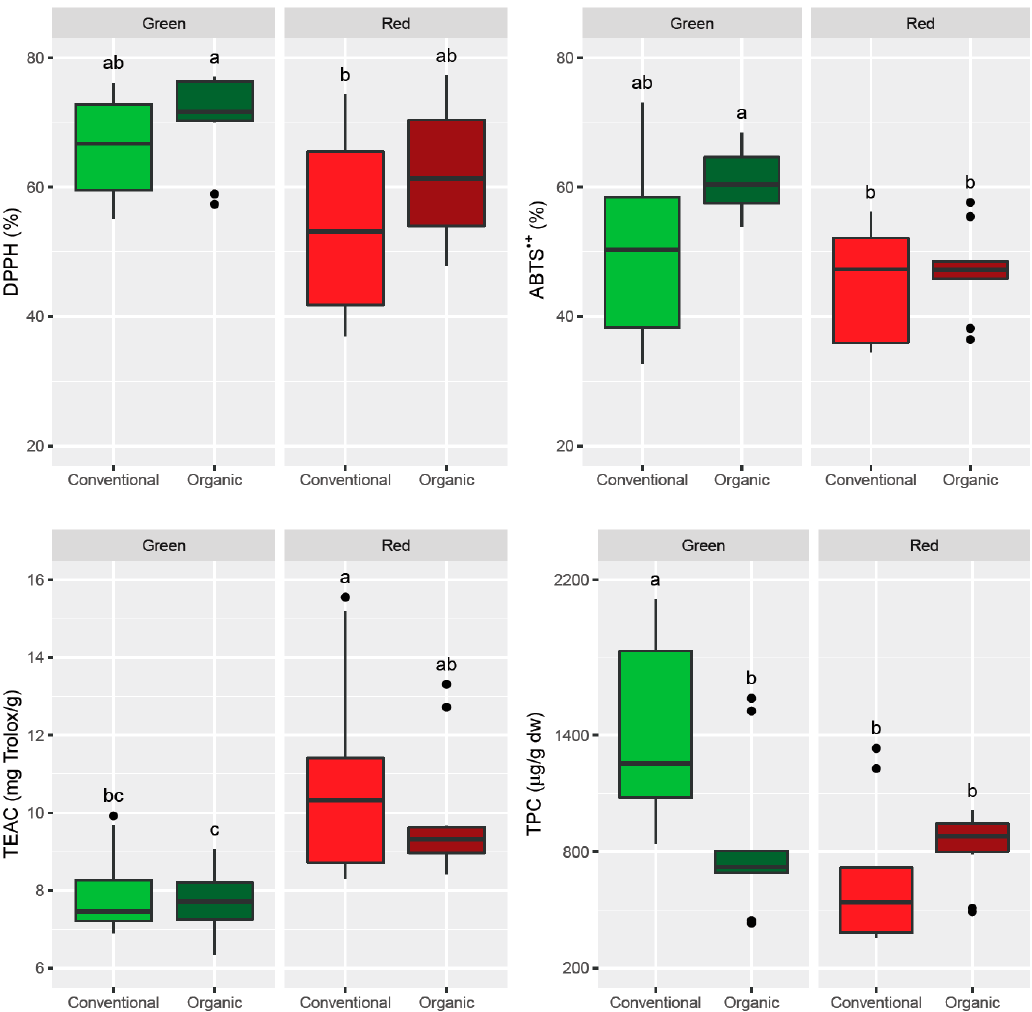
Figure 2. Antioxidant activities (DPPH, in %; ABTS • + , in %; and, TEAC, in mg Trolox g − 1 ) and total phenolic contents (TPC) (sum of individual phenolics, in µ g g − 1 dw) of sweet peppers according to the maturation stage (green or red peppers) and agronomic production system (conventional or organic systems). Box bars represent the values that are within the 1st and 3rd quartiles and the horizontal line represents the 2nd quartile (median). Vertical lines from the middle of the top and bottom edges of each box represent the whiskers. Dot points represent minimum or maximum values that fall outside the whisker range (extreme values or outliers). Different lower case letters mean significant statistical differences ( p -value < 0.05) among maturation–production levels.